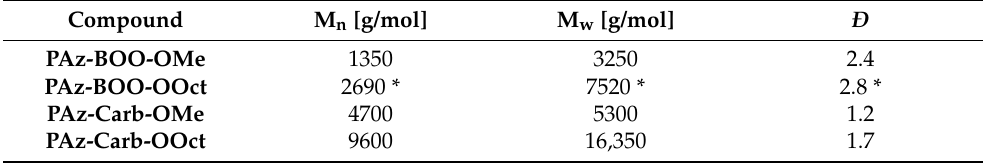
Table 2. Molar masses and molar mass dispersity of investigated polyazomethines.